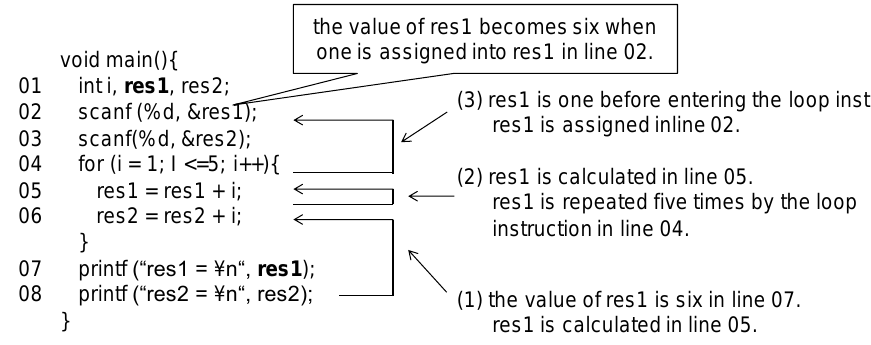
Figure 4. Sample program for explanation of the proposed method.